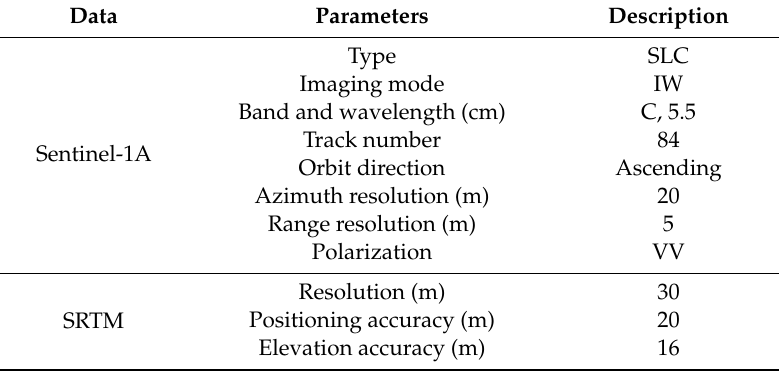
Table 1. The specific information of Sentinel-1A images and SRTM data. SLC represents single look complex image, IW represents interferometric wide swath, VV represents vertical